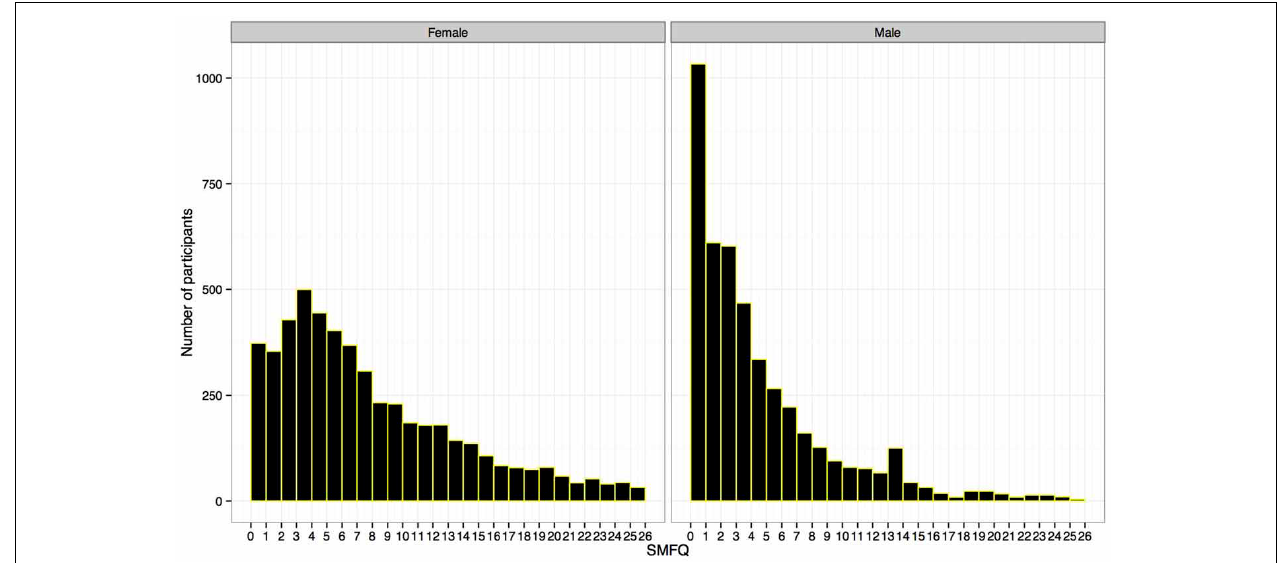
FIGURE 1 | Distribution of scores on the Short Mood and Feelings Questionnaire (SMFQ), given in separate plots for females (to the left) and males (to the right).